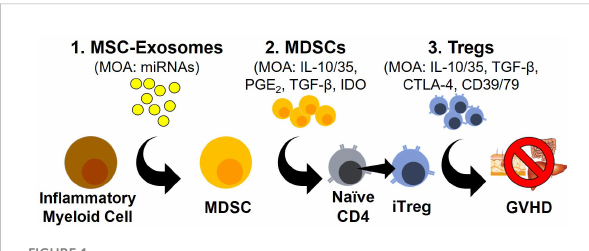
FIGURE 1 Novel Modalities For GVHD Prophylaxis/Treatment. Schematic outlining three emerging approaches to GVHD prophylaxis and treatment with their corresponding mode of actions